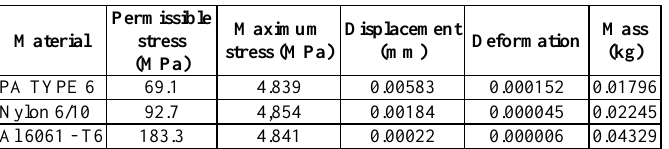
Table 8: Result of the wheel analysis, with comparison between materials.